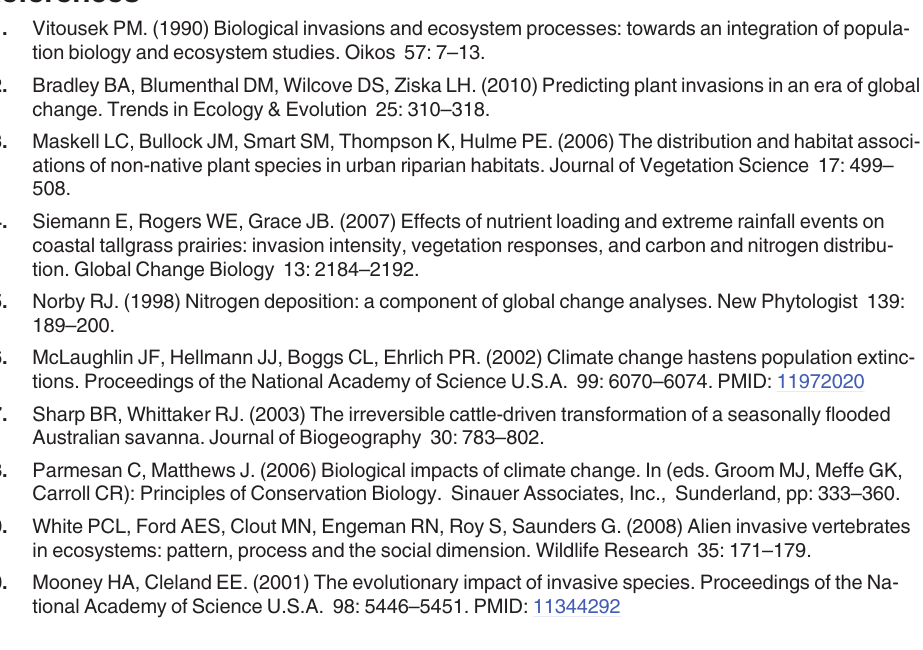
S2 Fig. Mean ± SD for the 15 most abundant plant species found across plots. (A) control, (B) nitrogen, and (C) warming treatments in the absence (white bars) and presence (black bars) of invasion. Species are arranged in functional groups. Annual herbs: AMAR = Ambrosia artemisiifolia , TRDI = Trichostema dichotomum . Perennial herbs: SOCA = Solidago canaden-